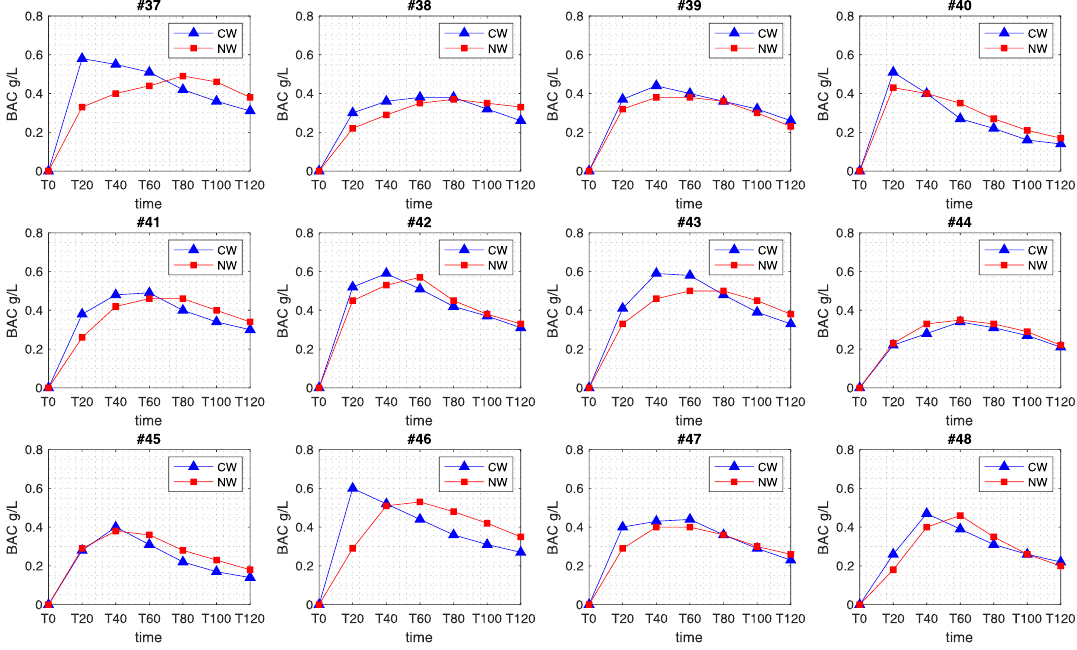
Figure A4. Concentration – time curves of BAC responses to natural wine and conventional wine for subjects #37 – #48.